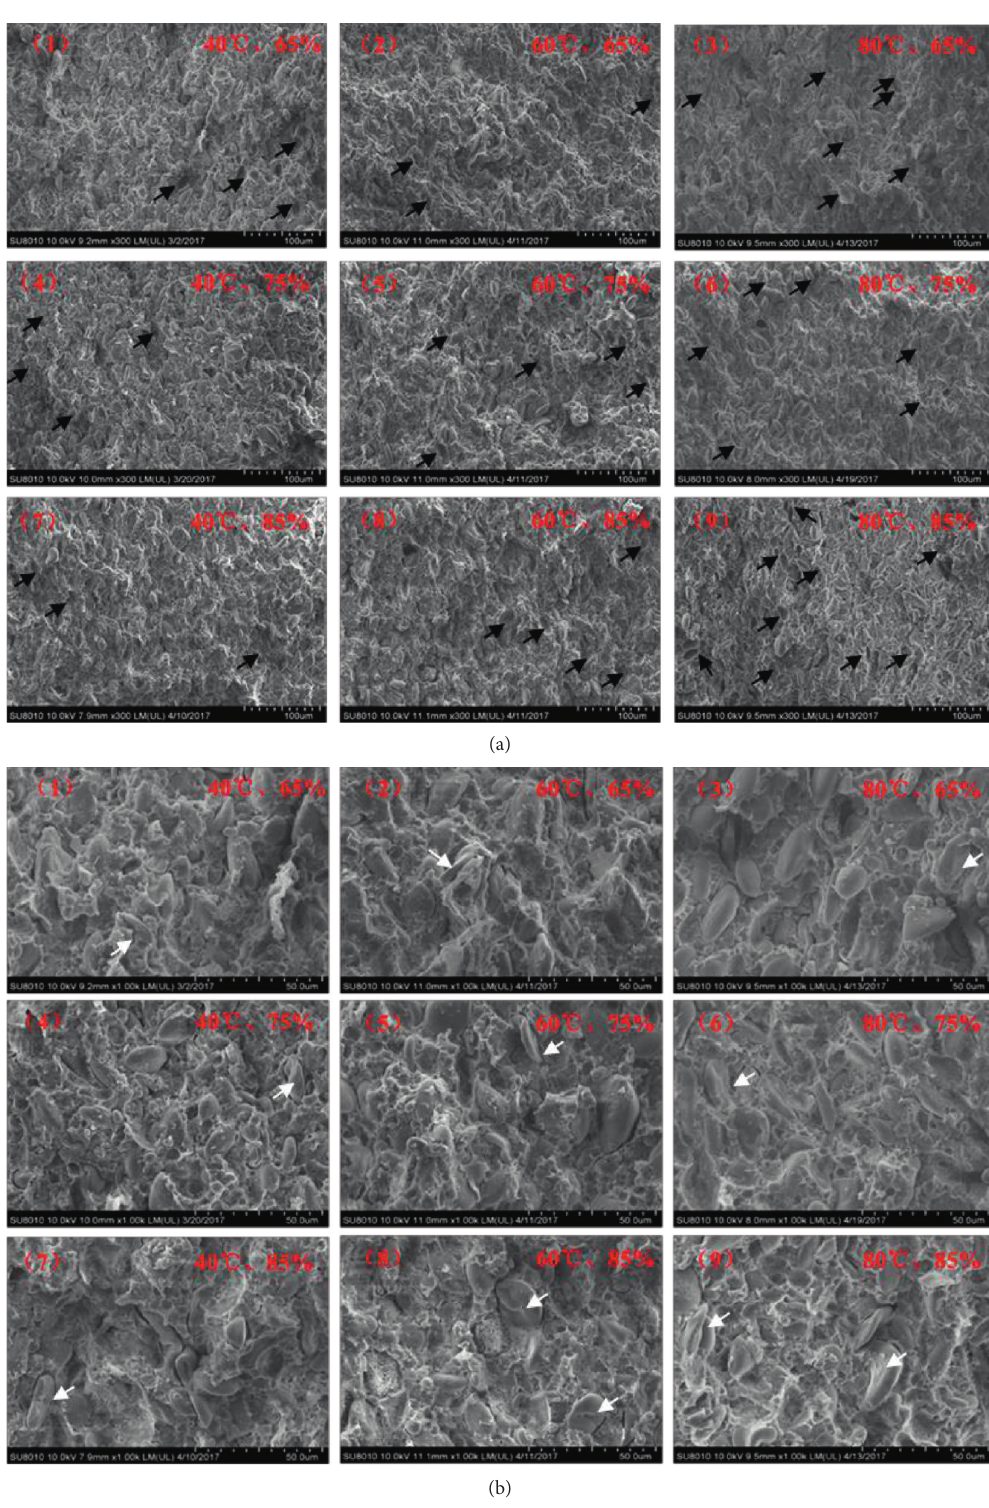
Figure 1: SEM of cross sections of CDN at different drying temperatures and relative humidities ((a) × 300; (b) ×